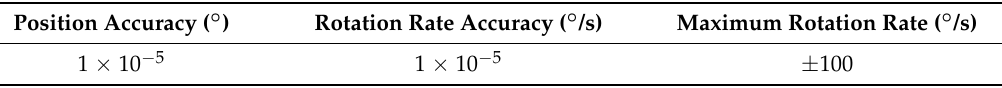
Table 2. Technical parameters of tri-axial rotation platform.